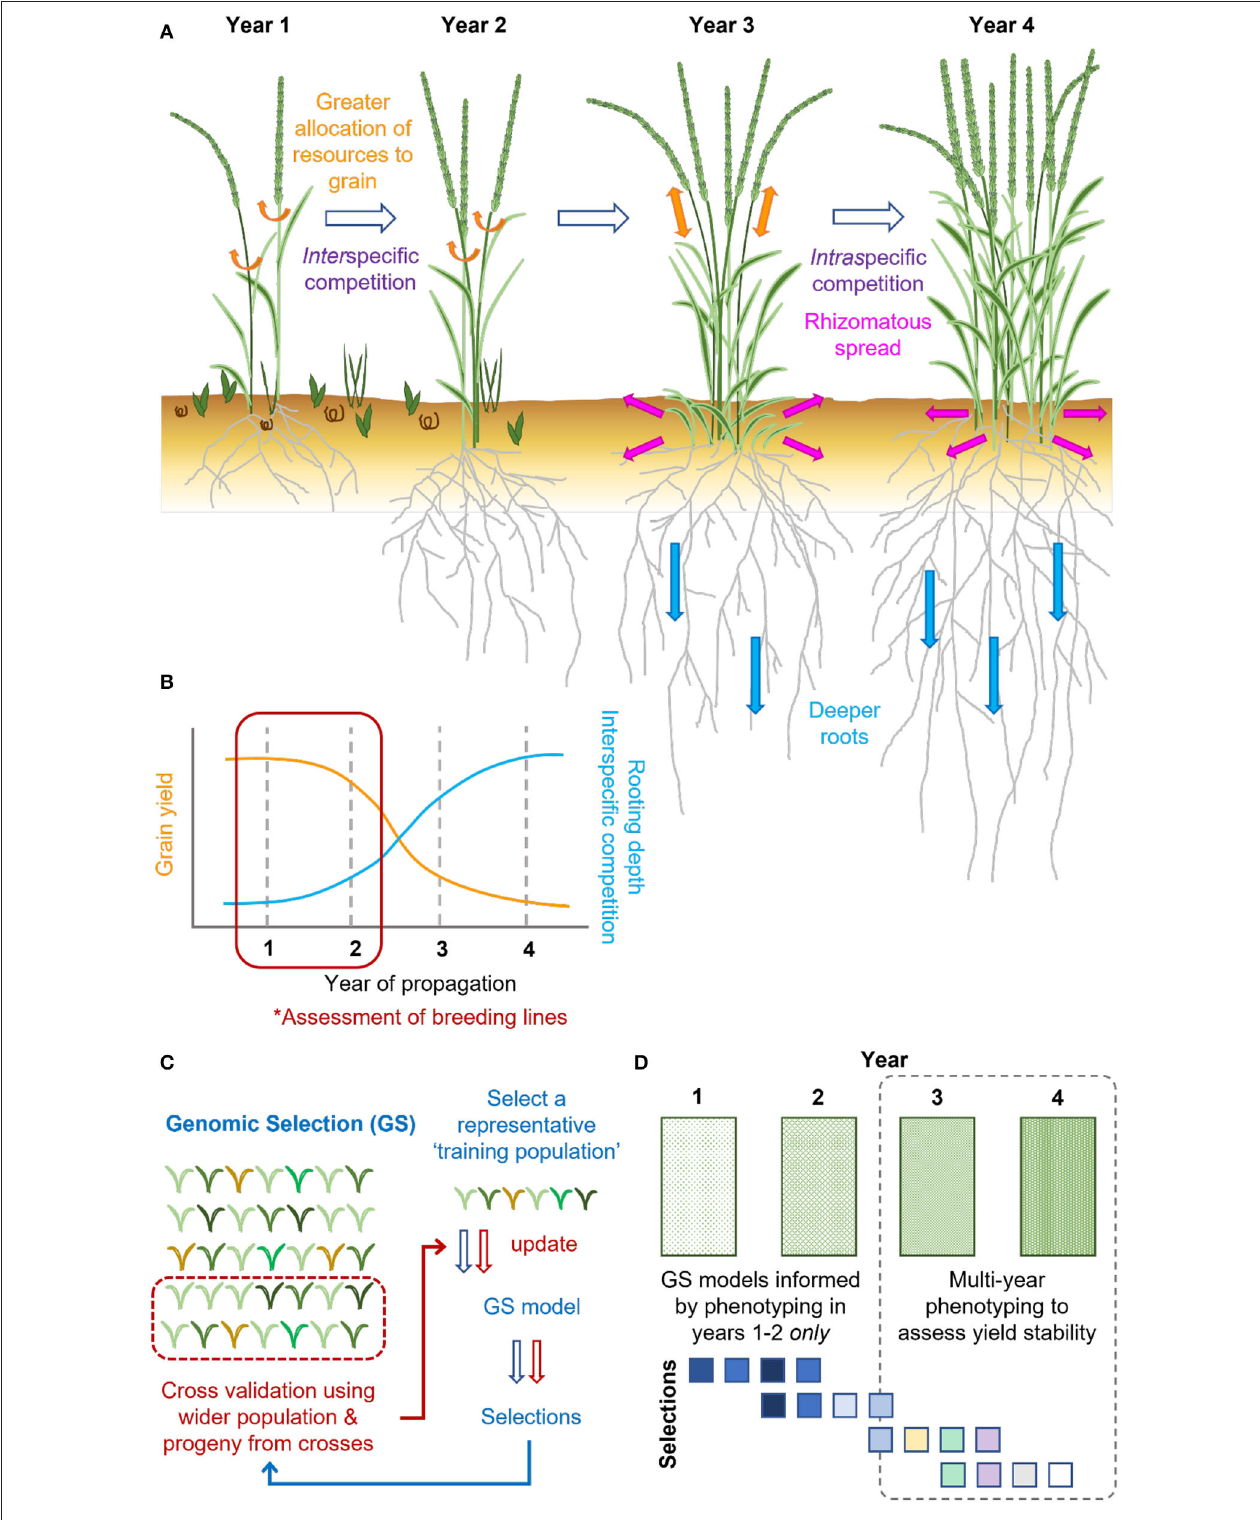
FIGURE 2 | Grain yield of intermediate wheatgrass ( T. intermedium ) varies over time, which existing genomic selection practices need to be designed to overcome. (A) Grain yield of intermediate wheatgrass is typically greatest in the first 2 years of propagation, with stem reserves and photosynthates allocated toward the